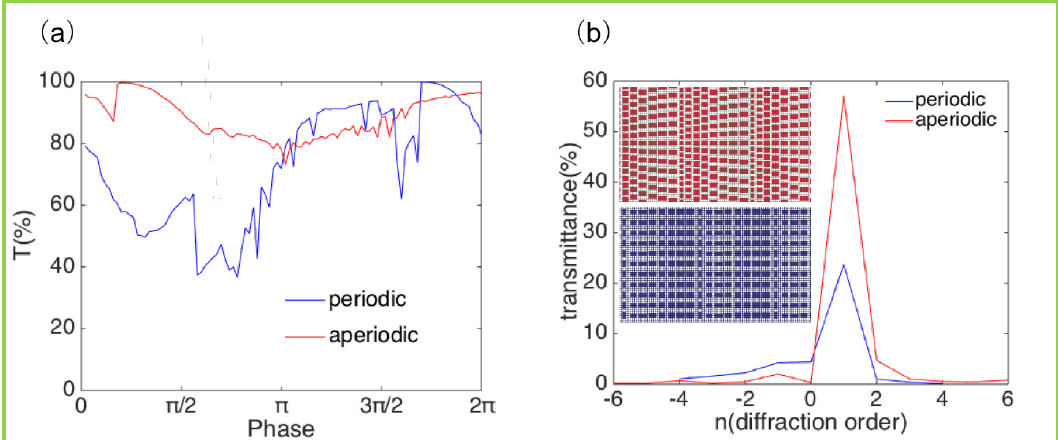
Figure A1. ( a )The highest transmittance achieved by the comparison of periodic (blue) and aperiodic (red) nanoblocks in the 0–2π full-phase space, which shows that aperiodic significantly improves the corresponding efficiency. ( b ) Contrast diagram of far-field radiation intensity. The inserted red image is the grating composed of aperiodic meta-atoms, and the blue image is the grating composed of periodic meta-atoms.